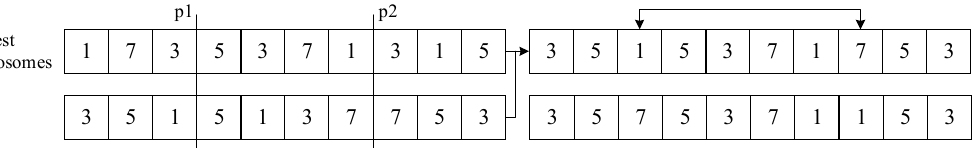
Figure 4. Schematic diagram of scout bees’ search operation.